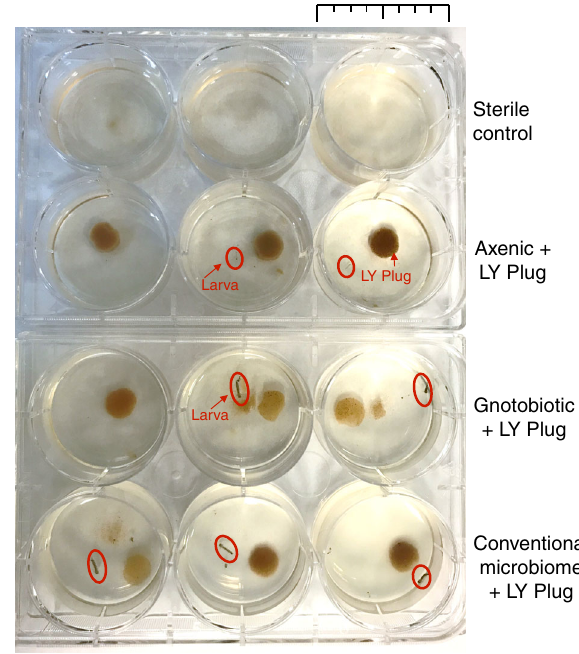
Fig. 1 Experimental setup. Individual larvae were reared in the wells of a six- well plate. This picture was taken 5 days post hatching. The sterile control group consisted of autoclaved liver:yeast extract not embedded in an agar plug, which does not support larval development (individual larvae in this group are too small to see at this scale). Any development of sterile control larvae was taken as a sign of contamination and the experiment was discarded. Because of the delay in development, the axenic larvae are smaller than the gnotobiotic or CM groups. The scale bar at the top of the fi gure denotes 3.5 cm. The red arrow and text indicate the LY plug. The red circles highlight the individual larvae in the wells